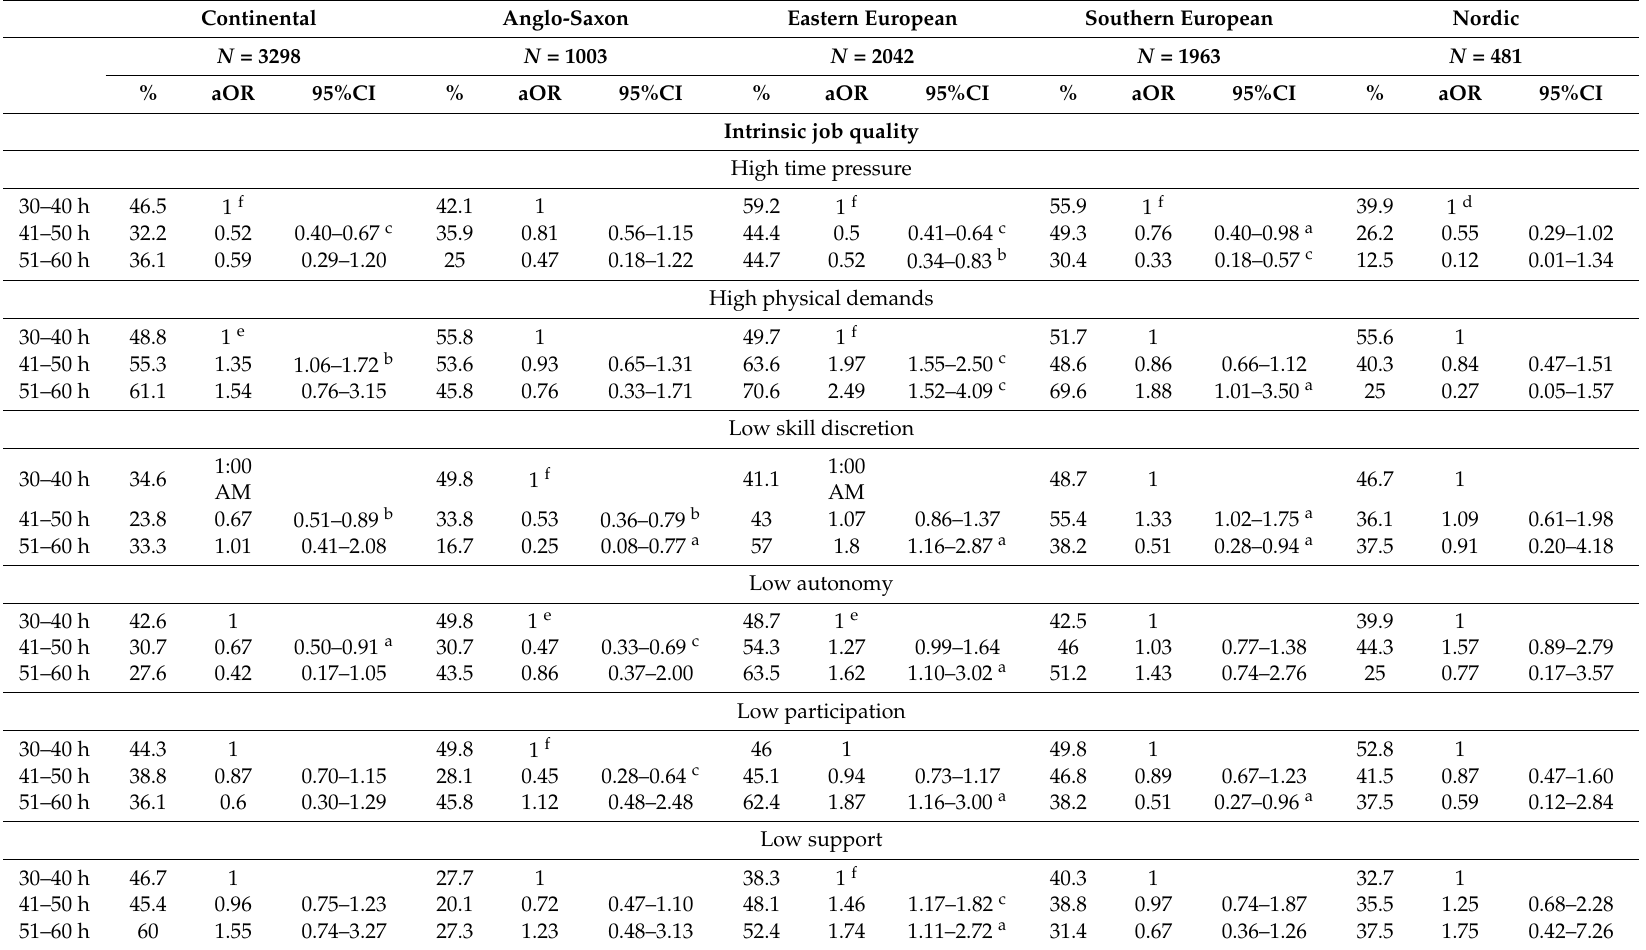
Table 3. Association of working time with poor job quality by country group among women. Adjusted odds ratios (aOR) and 95% confidence intervals (95% CI). Employees working 30–60 h a week. 5th European Working Conditions Survey,